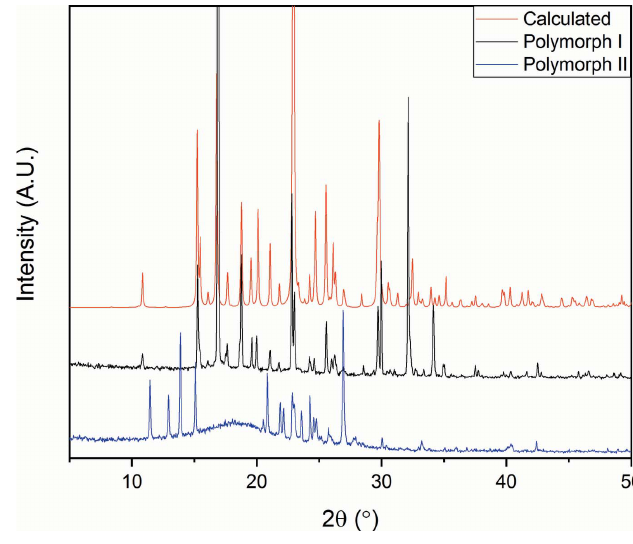
Figure 8 Powder X-ray diffraction measurements of form I (black) and II (blue) of 3,4-DMBz. The powder pattern (red) was calculated from the crystal structure by de Ronde et al. (2016).